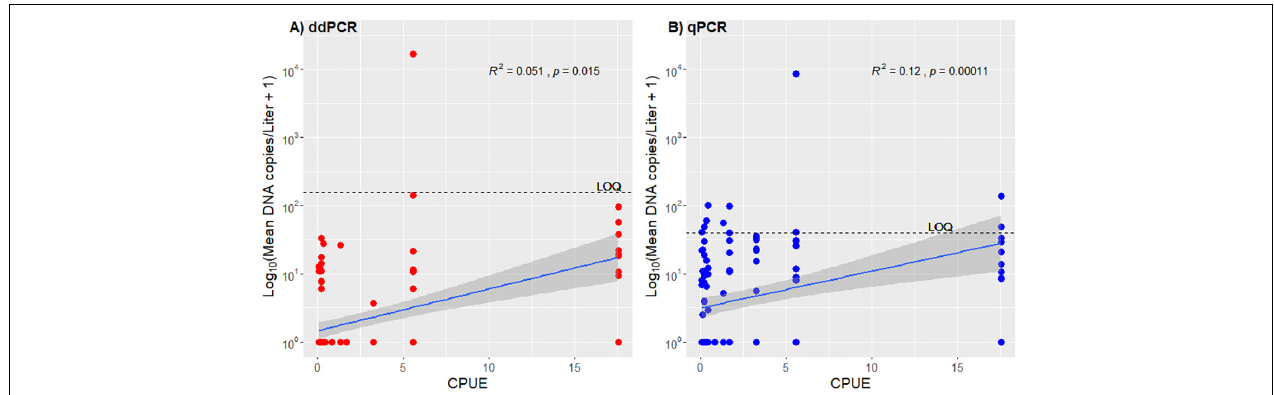
FIGURE 8 | (A) A scatterplot with correlation (Spearman) of the mean DNA copies per liter for each sample from ddPCR plotted against CPUE of crayfish. The horizontal line indicates the LOQ of ddPCR adapted to fit the copies per liter values. (B) A scatter plot with correlation (Spearman) of the mean DNA copies per liter for each sample from qPCR plotted against CPUE of crayfish. The horizontal line indicates the LOQ of qPCR adapted to fit the copies per liter values.